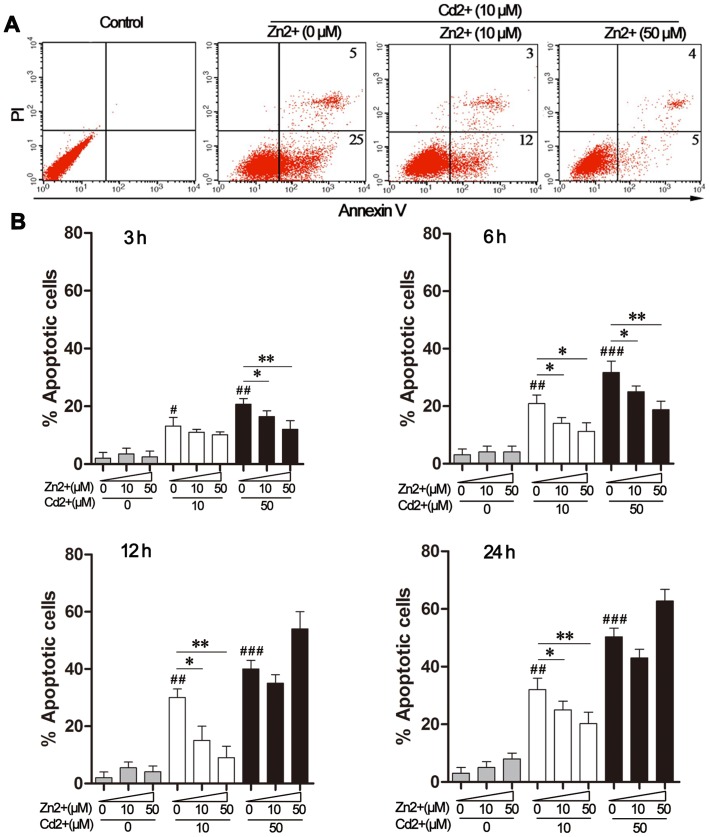
Effects of Zn2+ and Cd2+ on MDBK apoptosis.(A) MDBK cells were treated with 10 μM CdCl2, alone or in combination with ZnCl2 (0, 10, or 50 μM), for 12 h. Apoptotic cell death was quantified by flow cytometry following double staining with propidium iodide (PI) and a fluorescein isothiocyanate (FITC)-conjugated annexin V antibody. Control cells were treated with medium. (B) MDBK cells were treated with CdCl2 alone (0, 10, or 50 μM) or in combination with ZnCl2 (0, 10, or 50 μM) for the indicated time periods. The percentage of PI- or annexin V-positive apoptotic cells was quantified by flow cytometry. The data were expressed as the mean ± SD (n = 4). #P<0.05, ##P<0.01, and ###P<0.001 for the comparison with the medium-treated control group; *P<0.05 and **P<0.01 compared to cells exposed to Cd2+ only (10 or 50 μM).